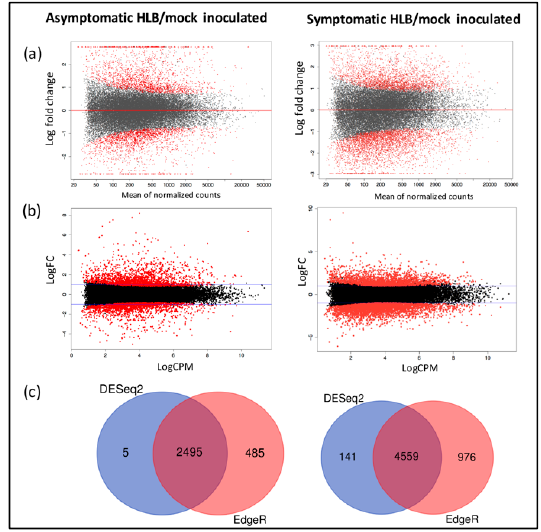
Figure 2. CLas titer quantification and symptoms of selected samples for RNA-seq analysis. ( a ) Bacterial titer in Mexican lime leaves of the five individual plants included in each library at 8 and 16 weeks post-inoculation (wpi). L8wpiHLB+1 and L8wpiHLB+2 are two replicates of asymptomatic plants at 8 wpi. L16wpiHLB+5 and L16wpiHLB+6 are two replicates of symptomatic plants at 16 wpi. L8wpiHLB-3 and L8wpiHLB-4 are control plants (mock-inoculated) at 8 wpi, and L16wpiHLB-7 and L16wpiHLB-8 are control plants (mock-inoculated) at 16 wpi. For each bar, standard deviation is shown. N.D: not detected. ( b ) Representative pictures of Mexican lime leaves used as source of biological material in the present study.